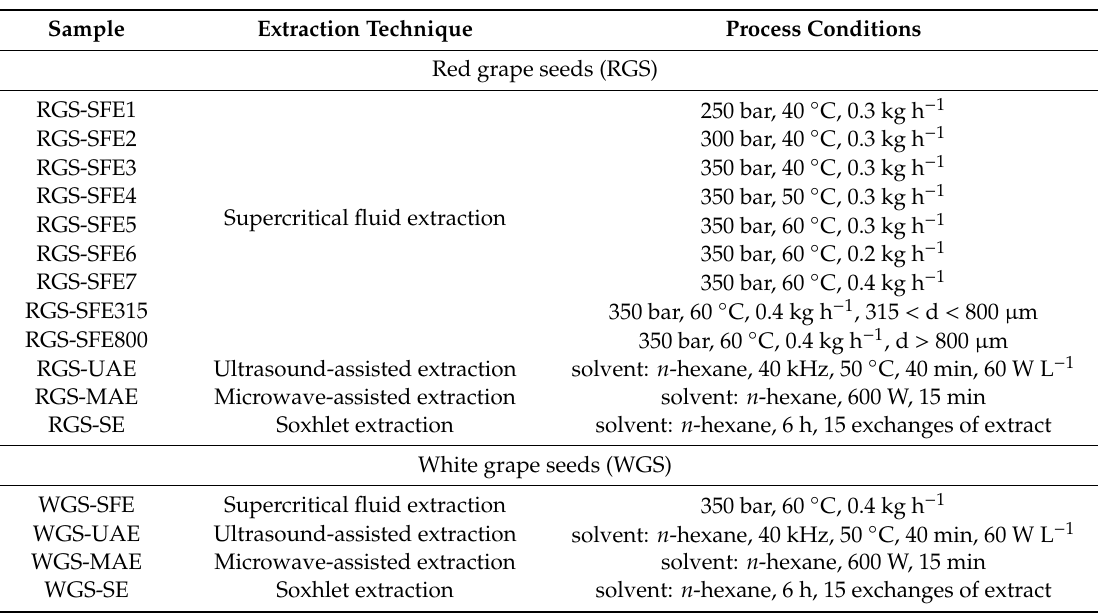
Table 1. Design of an experiment for grape seeds oil